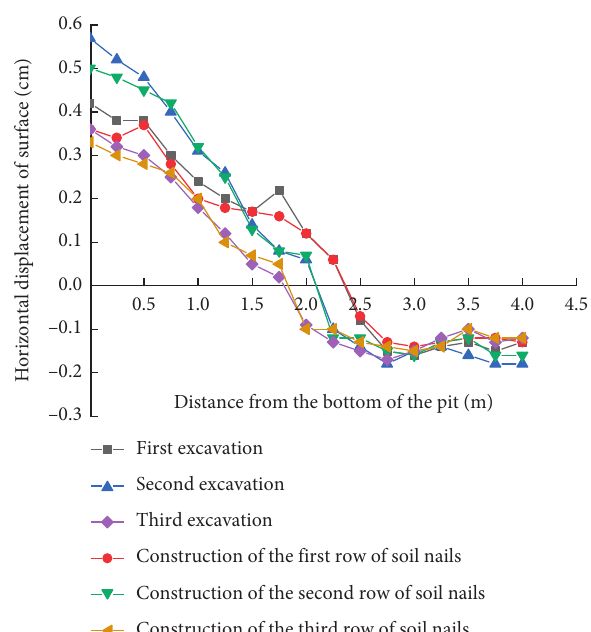
Figure 12: Displacement curves of the pit wall surface